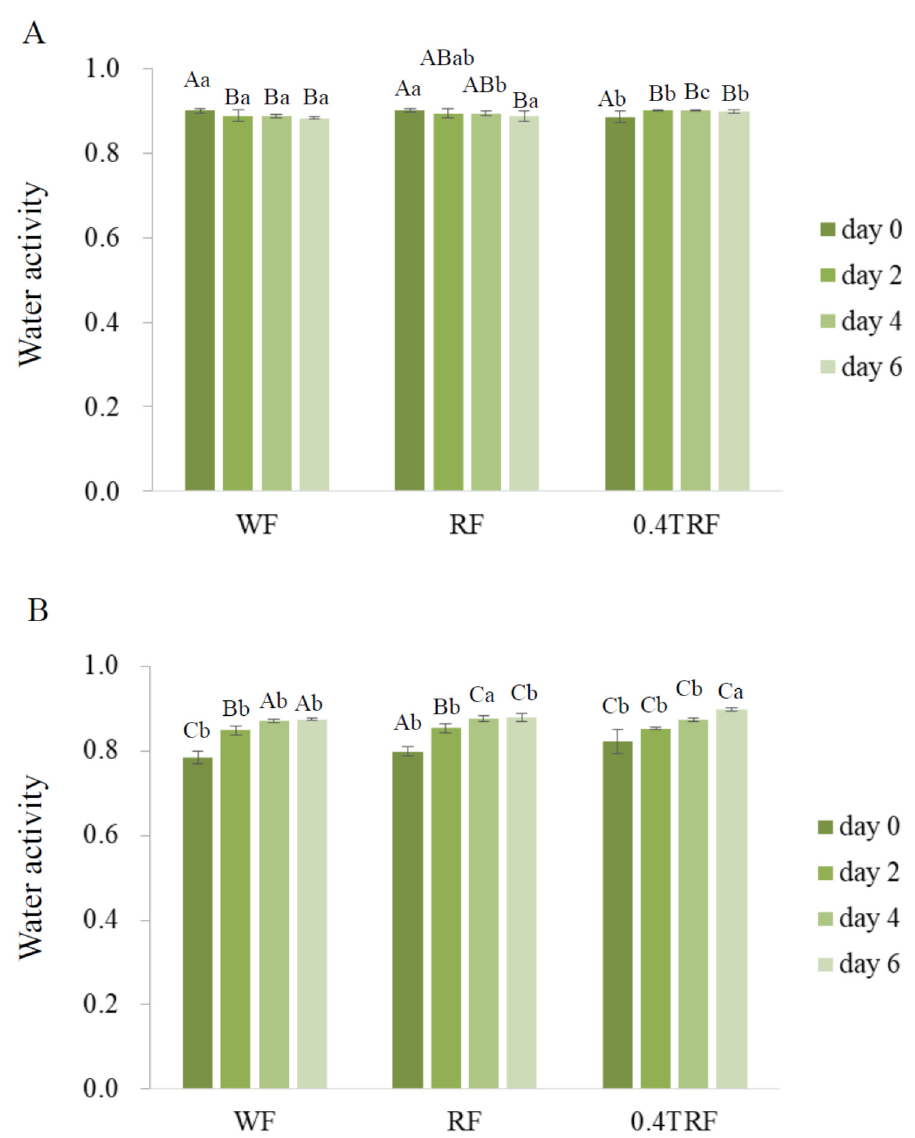
Figure 4. Water activity change of cake and gluten-free cake: crumb ( A ) and crust ( B ). a-b Di ff erent letters indicate significant di ff erence between di ff erent samples (n = 3; p < 0.05). A-C Di ff erent letters indicate significant di ff erence between di ff erent days (n = 3; p < 0.05). WF: cake made with 100% wheat flour; RF: gluten-free cake made with 100% rice flour; 0.4TRF: gluten-free cake with 0.4% tamarind seed gum addition.